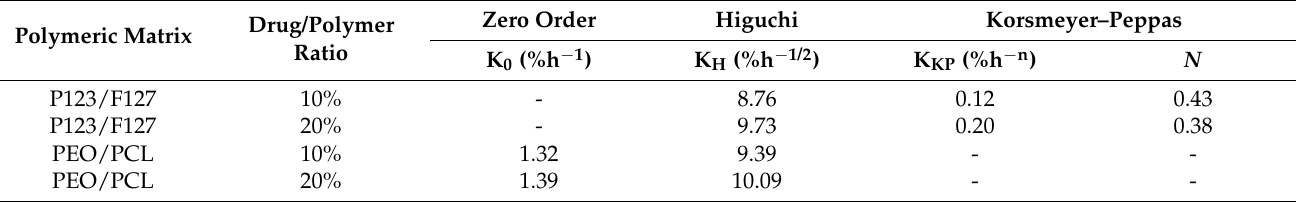
Table 7. Release kinetic constants obtained from statistical